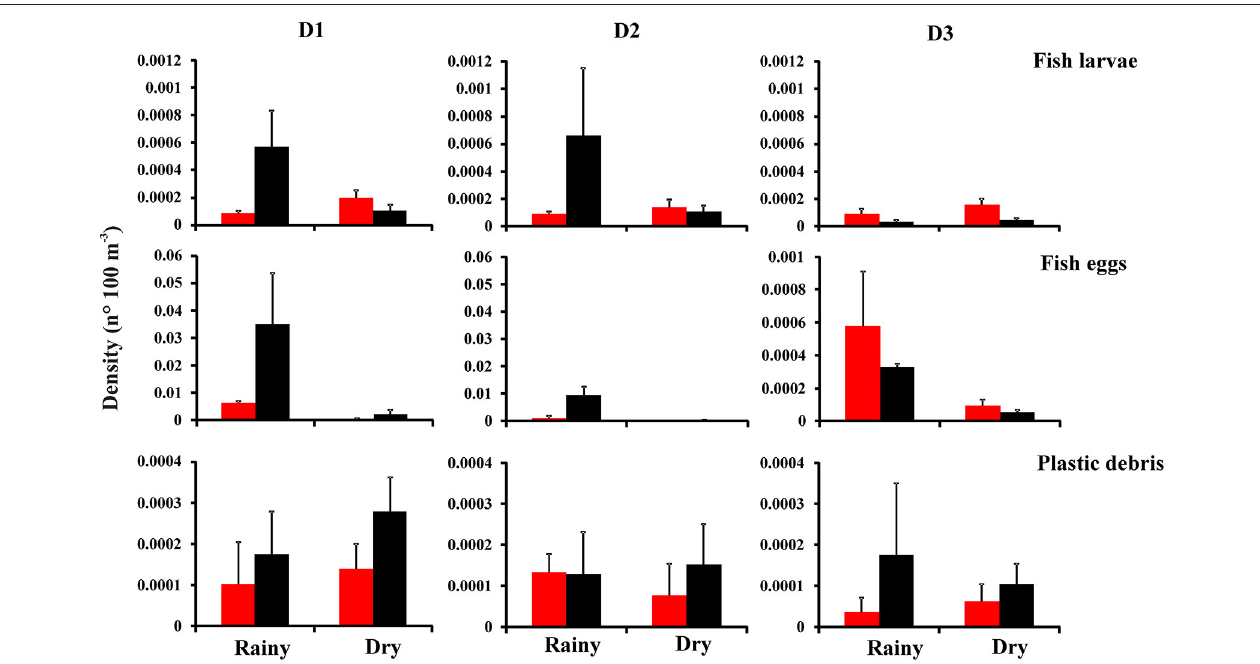
FIGURE 4 | Total mean ( + S.E.) density of ichthyoplankton (fish larvae and fish eggs) and plastics in different periods [( ) day and ( (cid:4) ) night] at D1 ( < 100 m), D2 ( > 100–500 m), and D3 ( > 500–1500 m) for each season (rainy and dry).